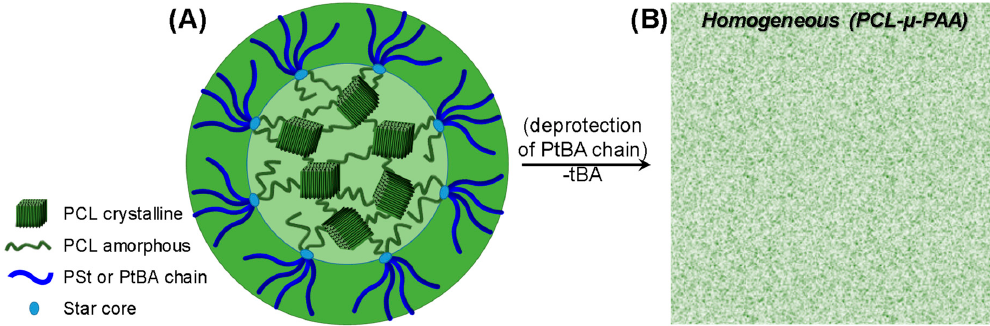
Figure 11. Proposed self-assembled microstructures of μ -star copolymers: schematic representation of ( A ) self-assembled microstructure from immiscible segments and ( B ) homogeneous surface from miscible segments.